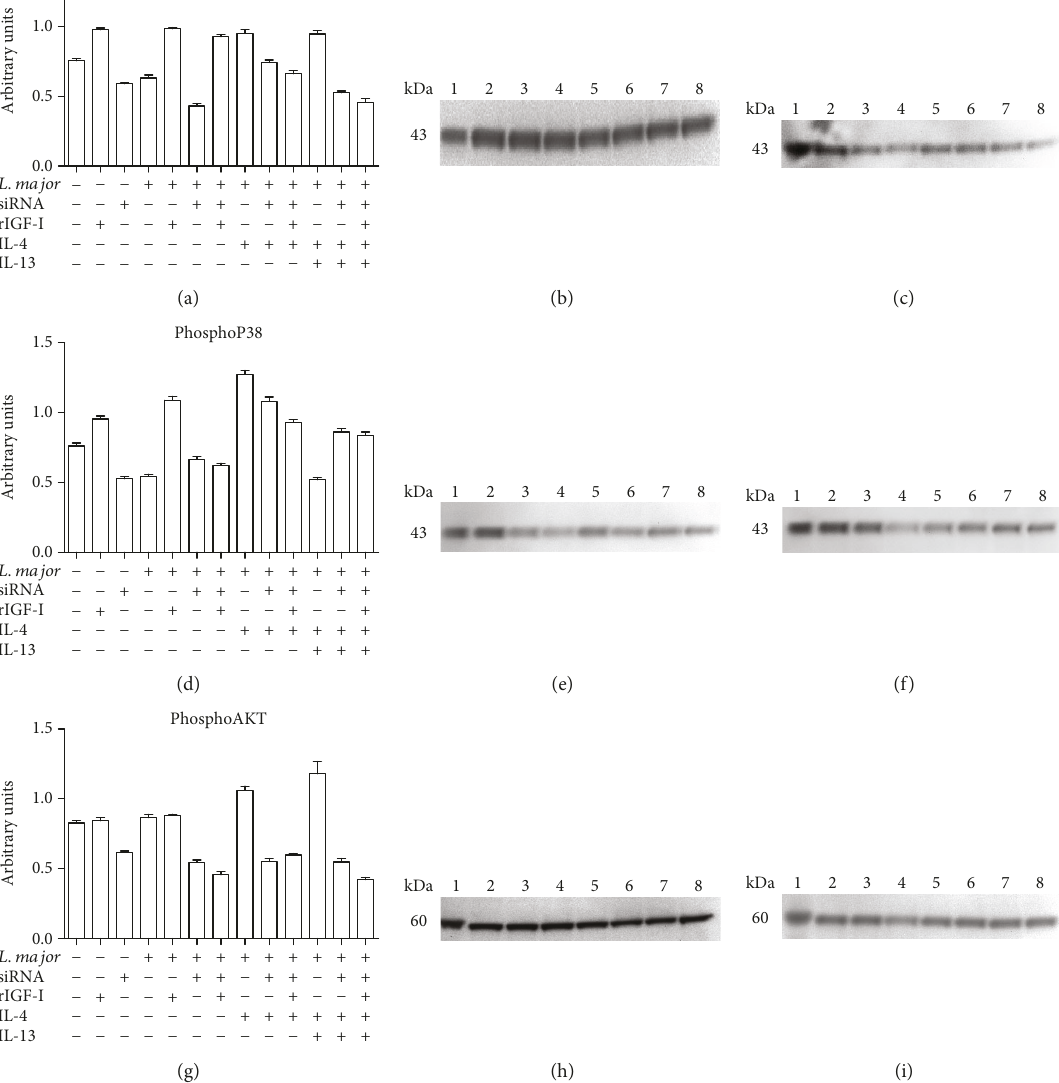
Figure 7: The e ff ects of siRNA and IL-4 on components of the IGF-I signaling pathways: levels of phosphorylated p44 (ERK), p38 (MAPK), and AKT proteins. Promastigote-infected or noninfected cells transfected with or without IGF-I siRNA were stimulated for 30 minutes with IL-4 (2 ng/mL) and IL-13 (5 ng/mL). Cells were lysed, proteins were separated by 10% SDS-PAGE, and subsequently, Western blotting was performed using anti-phospho-p44 (a, b, and c), anti-phospho-p38 (d, e, and f), and anti-phospho-AKT (g, h, and i) antibodies. Protein bands corresponding to protein expression levels were subject to a densitometric analysis, and the data are expressed in arbitrary units (a, d, and g). A representative blot is shown. (b, e, h) The lanes represented the following: 1: control; 2: RAW; 3: RAW +rIGF; 4: RAW+ siRNA; 5: RAW+ Lm; 6: RAW+ Lm+ rIGF; 7: RAW +Lm +IL-4; and 8: RAW +Lm +IL-4 +IL-13. (c, f, i): 1: control; 2: RAW; 3: RAW +Lm +siRNA; 4: RAW+ Lm+siRNA +rIGF; 5: RAW +Lm +siRNA +IL-4; 6: RAW+ Lm+ siRNA+IL-4 + rIGF; 7: RAW+ Lm+siRNA +IL-4 +IL-13; and 8: RAW+ Lm+ siRNA+IL-4 +IL-13 + rIGF. See Materials and Methods for additional